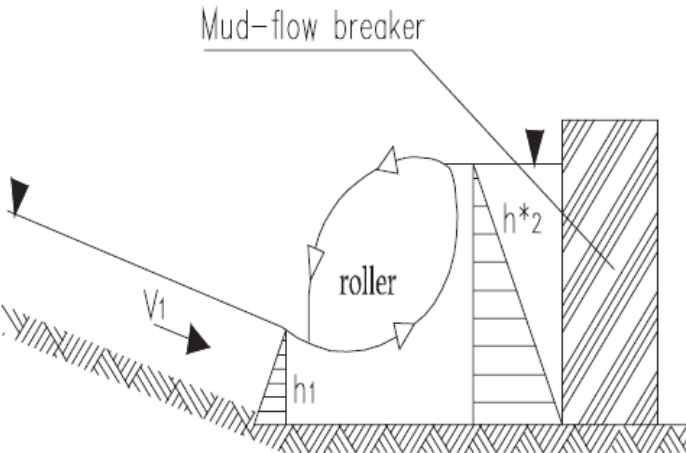
Figure 8. Representation of the roller forming upriver with respect to the flow breaker